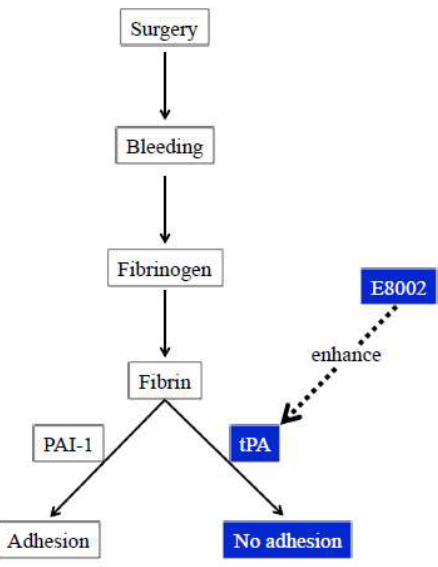
Figure 7. Schema showing the potential anti-adhesive action of L -ascorbic acid-containing E8002 via fibrinolysis. L -ascorbic acid-containing E8002 may exert an anti-adhesive effect by enhancing fibrinolysis. Boxes indicated in blue show mechanisms suggested by the current findings. tPA: tissue plasminogen activator; PAI-1: plasminogen activator inhibitor-1.